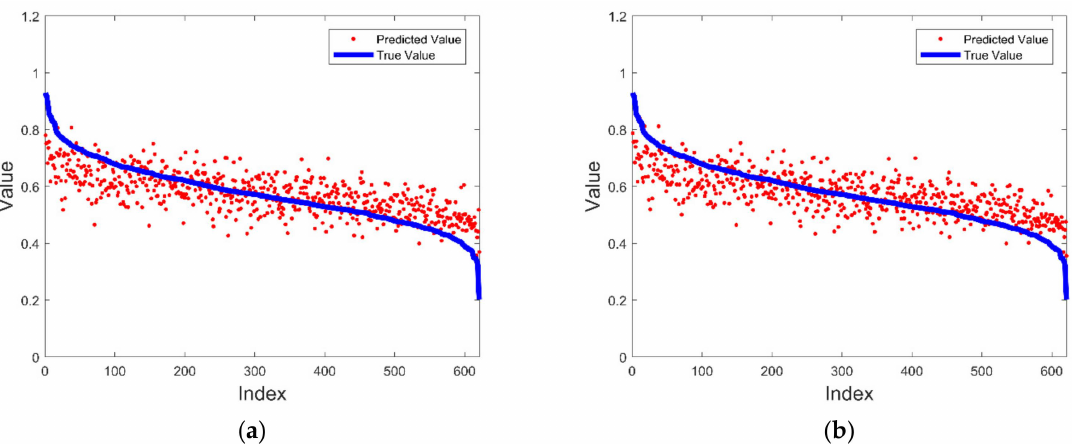
Figure 12. Election dataset prediction results obtained with the models fused with the numeric-type spatial weight matrix: ( a ) conventional LS-SVR model; ( b ) Geo LS-SVR model. Table 3. Evaluation index value comparison between the conventional LS-SVR and numeric-type Geo LS-SVR models. Evaluation